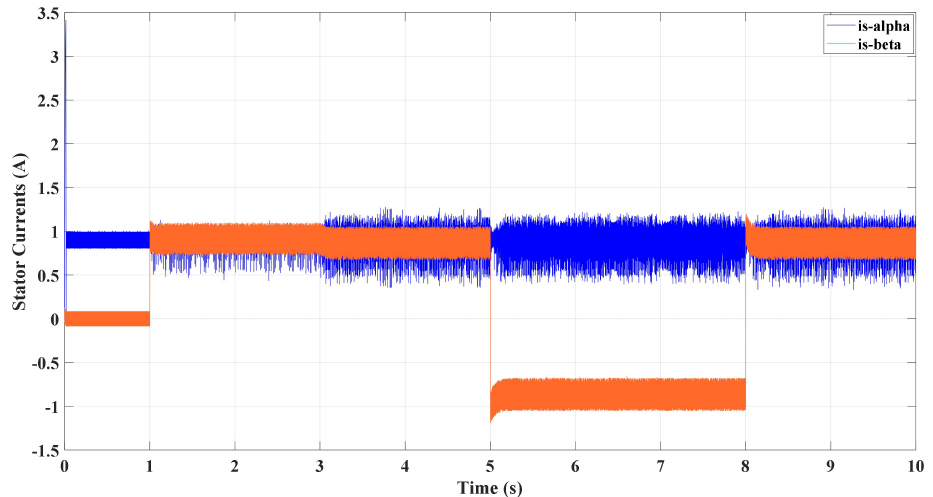
Figure 13. Two-phase currents for the conventional and improved